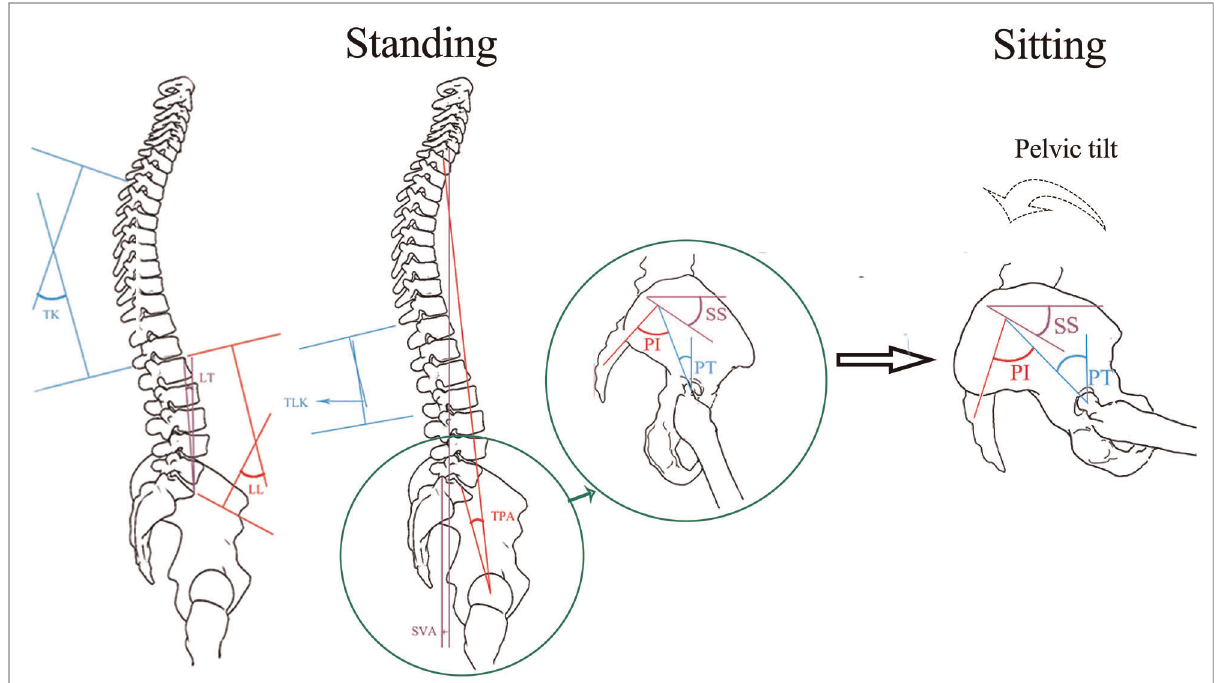
FIGURE 1 As the body posture changes from standing to sitting, the spinopelvic coordination maintains the sagittal balance of the body posture. See the “ Parameter measurement ” section for the description of spinopelvic parameters (PI, PT, SS, TK, LL, LT, TLK, TPA, and